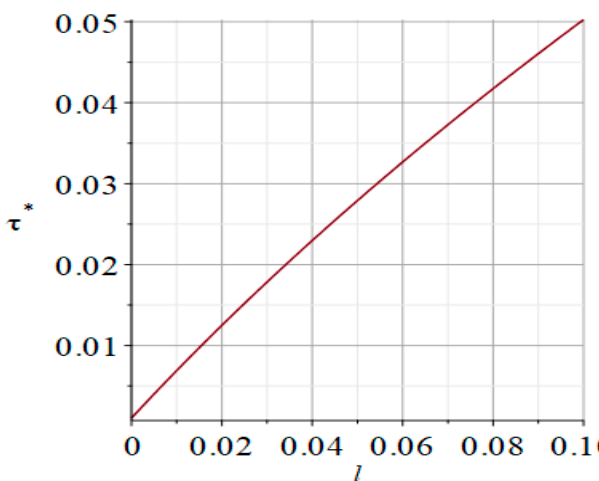
Figure 4. The relations between optimal deliberation time and customer deliberation cost ( k = 0.8; d = 0.2; c = 0.1, r p = 0.1, r s = 0.05, h =